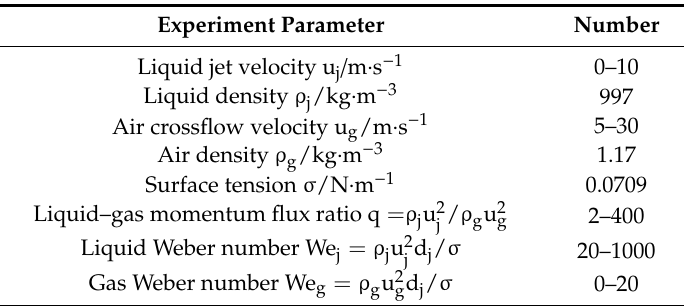
Table 1. Experimental conditions.